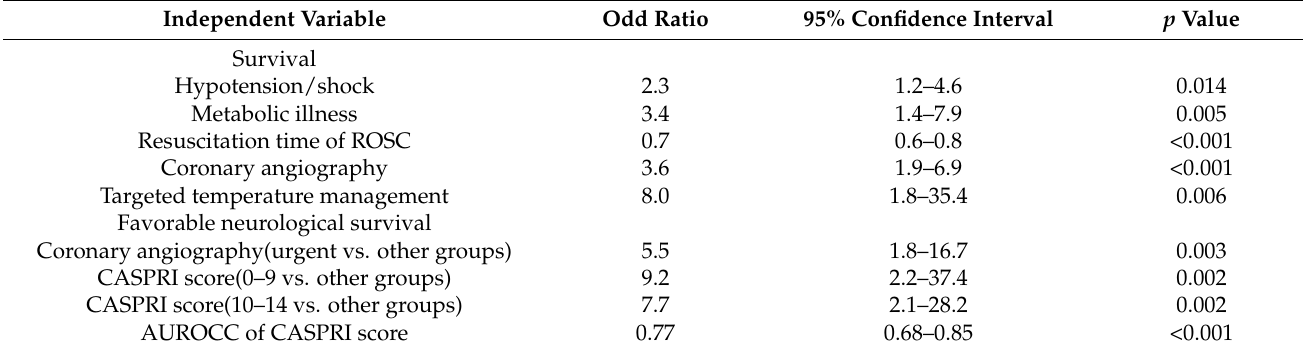
Table 4. Multivariate logistic regression and